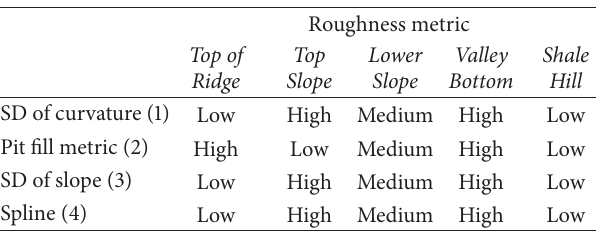
Table 3: Qualitative interpretive table used for visual interpretation. Landforms were delineated using these measurements. For example, Top of Ridge was delineated based on a low value for SD of curvature, a high value for the pit fill metric, a low value for SD of slope, and a low value for the spline.